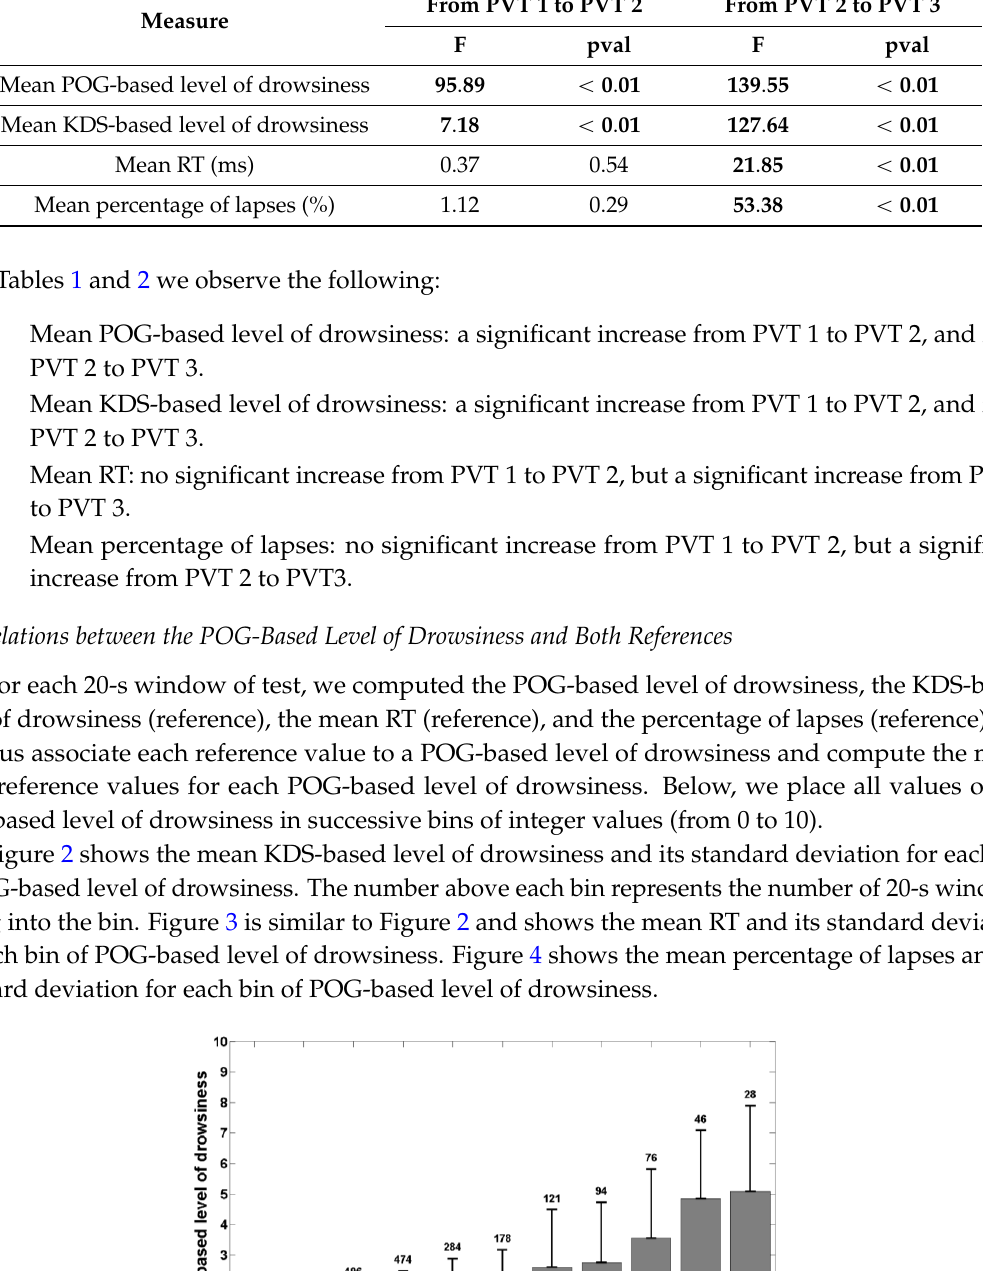
Figure 3. Mean reaction time as a function of POG-based level of drowsiness. Each bin represents the mean reaction time for each value of POG-based level of drowsiness. The error bars show the standard deviation around each mean value and the number above each bin indicates the number of 20-s windows falling into the bin.